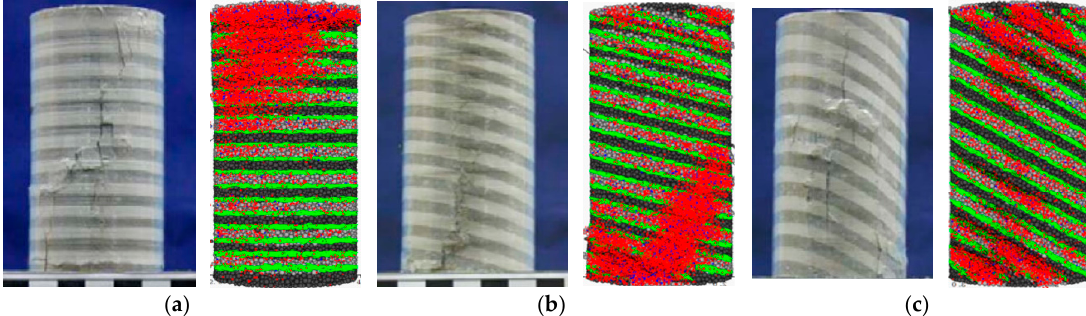
Figure 8. Failure modes of transversely isotropic jointed rock models having dip angles of ( a ) α = 0°, ( b ) α = 15°, and ( c ) α = 30°. (Note that the failure images of physical samples were adopted from Ref. [23]).